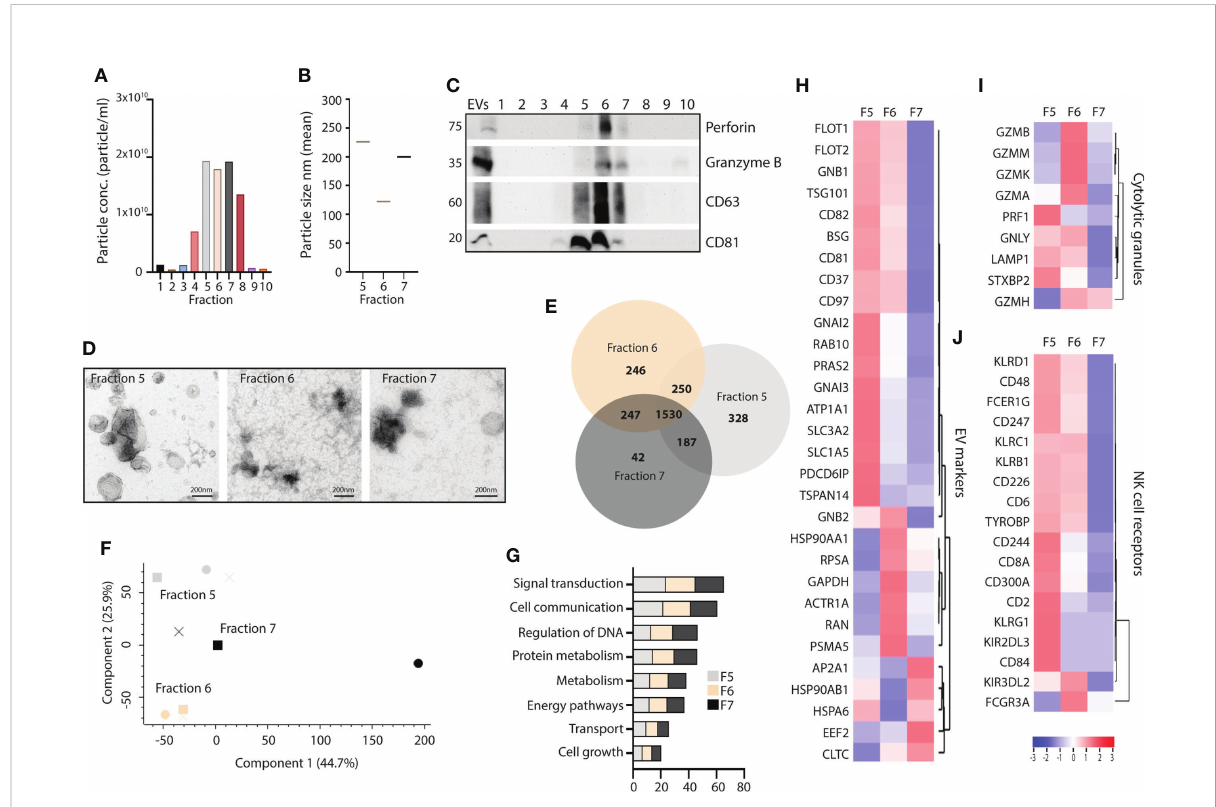
FIGURE 5 Comparison of fractionated subpopulations of primary NK-cell derived EVs via DG-UC. (A) Particle concentration of DG-UC fractions 1-10 measured by NTA. Data representing one biological experiment. (B) Particle size of DG-UC fractions 5-7 measured by NTA. Data representing one biological experiment. (C) Western blot analysis using 20 µg of EV isolates and whole cell lysate (wcl) of primary NK cells. Representative of three independent experiments. (D) TEM of DG-UC subpopulation 5-7. Scale bar 200 nm. (E) Venn diagram and (F) PCA analysis depicting differences in identi fi ed protein pro fi les between DG-UC fractions 5-7 by mass spectrometry. (G) FunRich biological pathway analysis of proteins identi fi ed DG-UC fractions 5-7 by mass spectrometry. (H) Heatmaps representing 3 three biological replicates of DG-UC fractions 5-7, represented by log2 mean intensity values of EV markers, (I) cytolytic granules markers and (J) NK cell